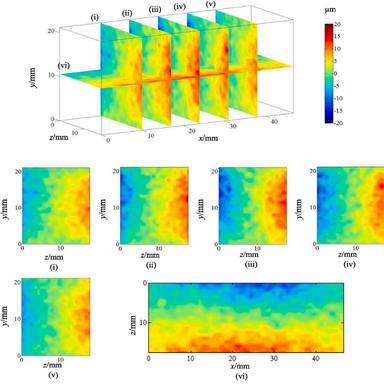
Three-dimensional (3D) inner displacement field at different positions of a sandwich beam specimen when the applied load is 1000 N . The copyright permission for this figure has been granted.